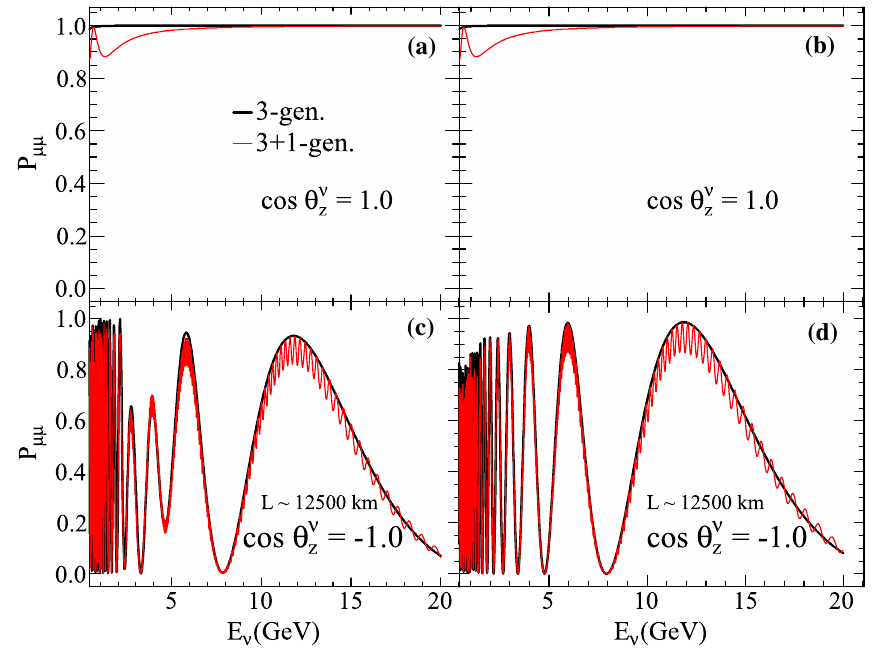
nos, L = 12 , 500km). The oscillation parameters assumed for all = 0 . 1eV 2 , panels are θ 24 = 10 . 0 ◦ , θ 14 = θ 34 = 0 . 0 ◦ , (cid:2) m 2 41 (cid:2) m 2 = 2 . 4 × 10 − 3 eV 2 , (cid:2) m 2 = 7 . 5 × 10 − 5 eV 2 , sin 2 θ = 0 . 5, 23 31 21 sin 2 θ 12 = 0 . 3, sin 2 2 θ 13 = 0 . 1 and all CP phases are taken as